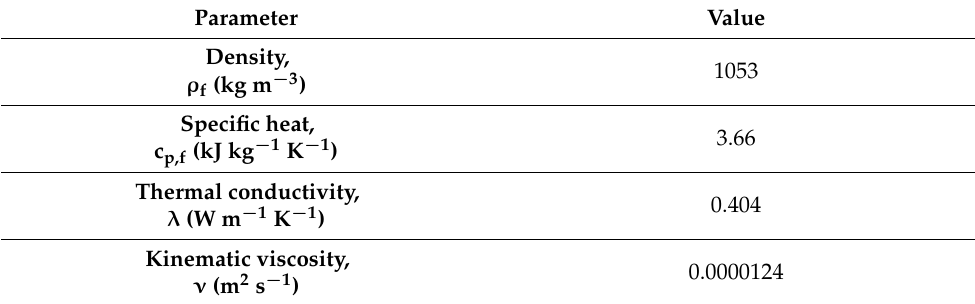
Table 1. The characteristic parameters of the water–glycol mixture used as a heat transfer fluid in the test installation: 33% water solution of propylene